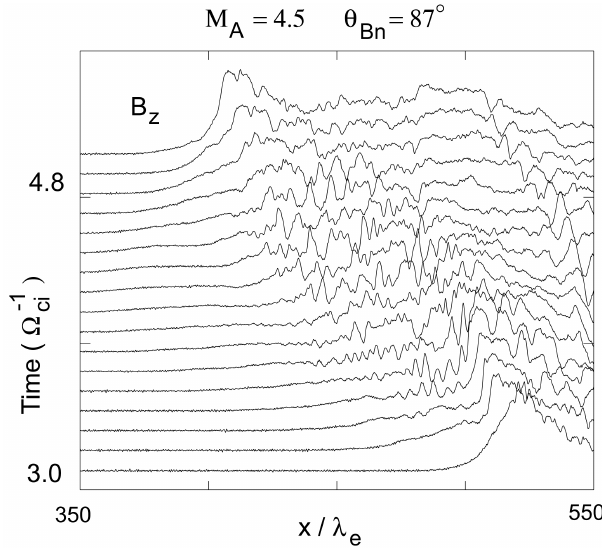
Fig. 6. Magnetic field B z component stacked in time for the ion to electron mass ratio 1840 run. Time runs from bottom to top.